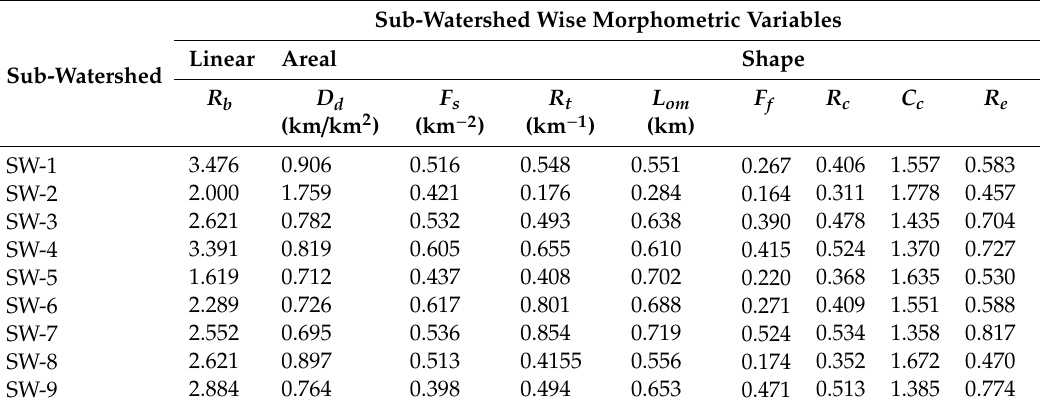
Table 5. Linear, areal, and shape variables of nine sub-watersheds of